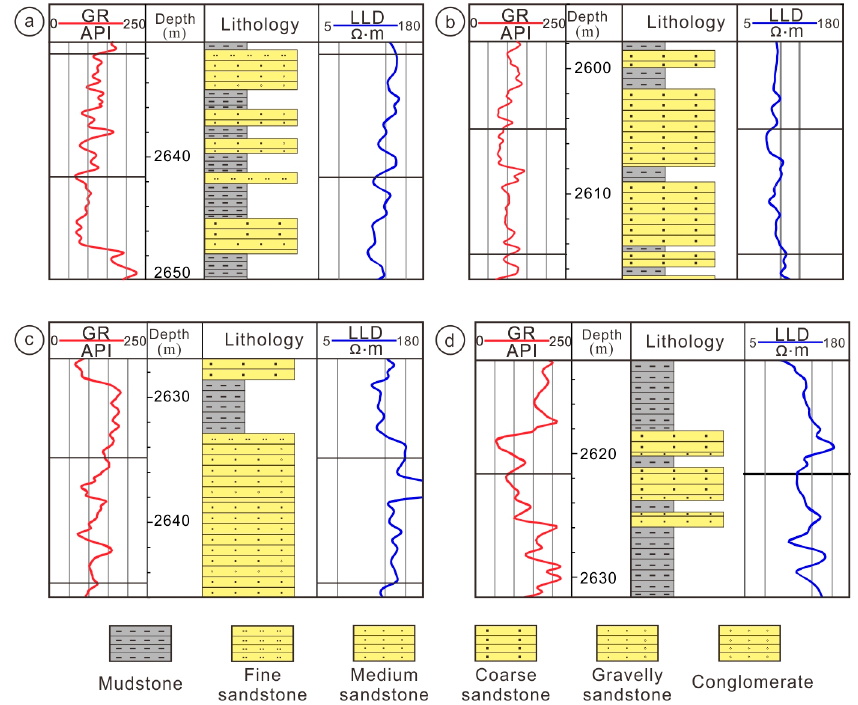
Figure 5. Section structure of braided river sedimentary facies in member H1. ( a ) Braided river, ( b ) channel bar, ( c ) braided channel, ( d ) interlayer.